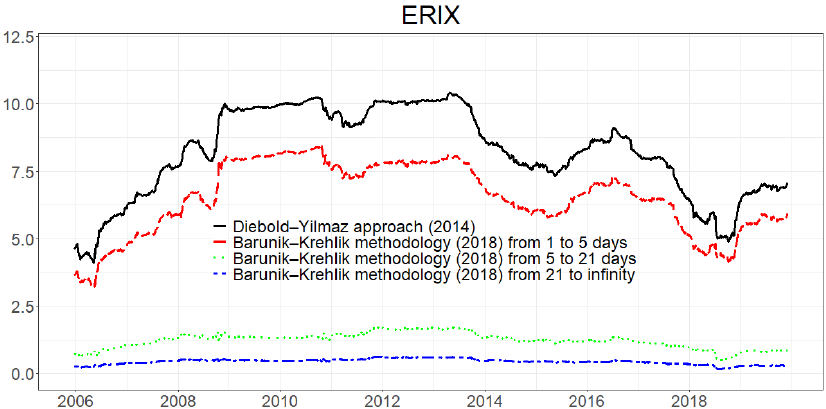
Figure 4. Diebold–Yilmaz [15] directional return spillover (from) and Barunik and Krehlik [16] directional return spillover (from) in Europe. Note: ERIX indicates European Renewable Energy Index.